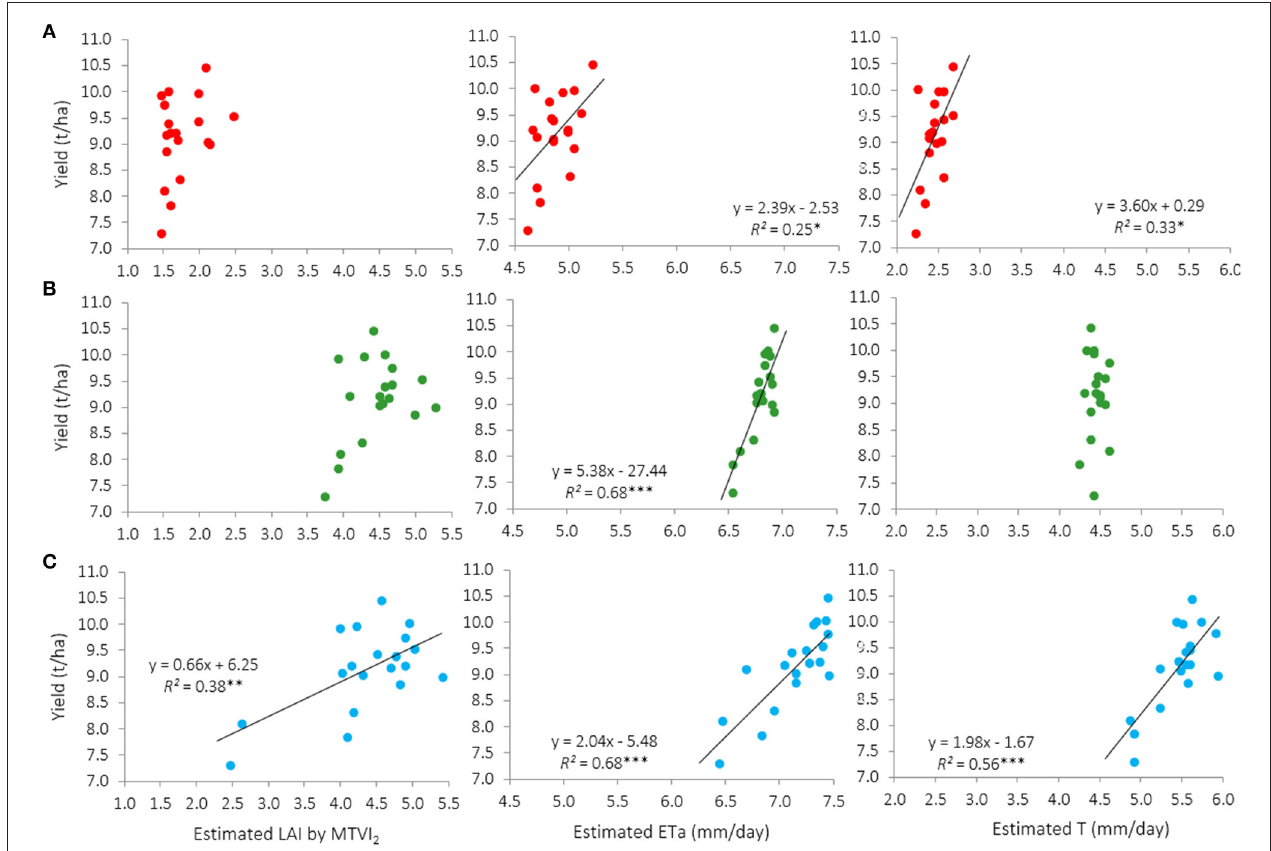
FIGURE 8 | Relationships between estimated LAI, actual evapotranspiration (ETa), and transpiration (T) assessed from remote sensing images and yield for the 100%ETc treatment for each image acquisition event: (A) April 4th (jointing), (B) April 30th (anthesis), and (C) May 22nd (grain filling). Each point represents the mean value of a genotype across replications ( n 19). Relationships involving predicted plant height are not shown because P > 0.05 in the three image acquisition dates. = *** P < 0.001; ** P < 0.01; * P < 0.05.